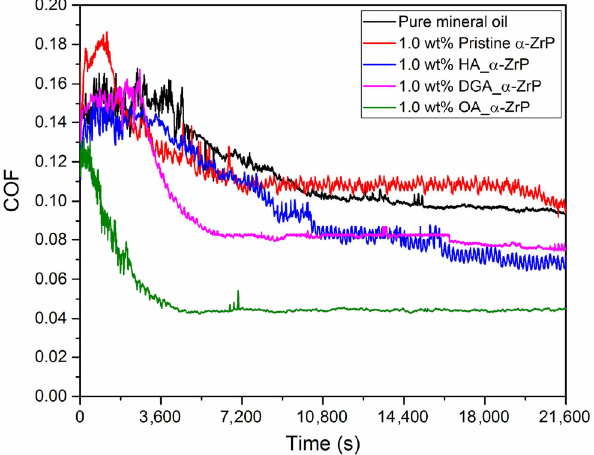
Fig. 10 Coefficient of friction as a function of time for pure mineral oil and mineral oil dispersions with 1.0 wt% pristine  -ZrP, HA_  -ZrP, DGA_  -ZrP, and OA_  -ZrP